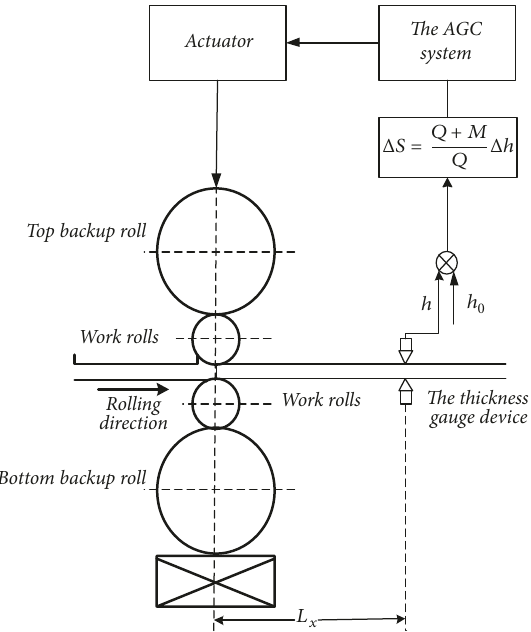
Figure 2: The structure of the monitoring AGC system.